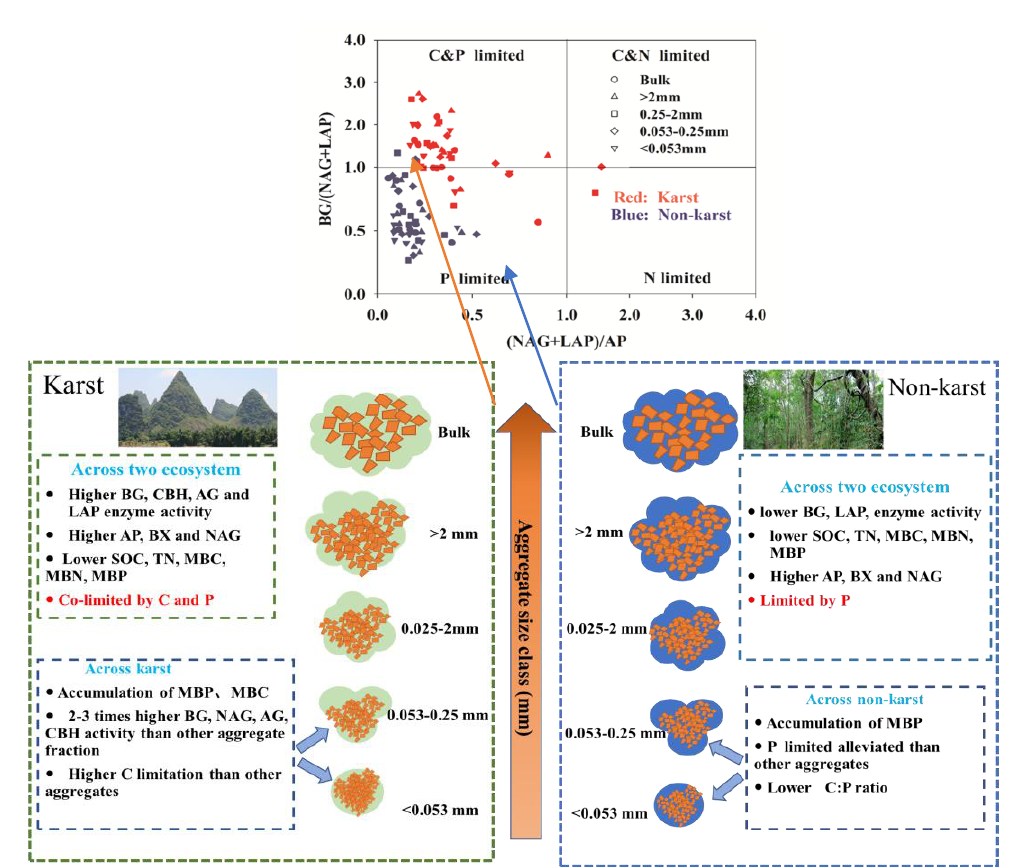
Figure 8. Conceptual diagram of the microbial resource limitations in aggregates between Karst and non-karst